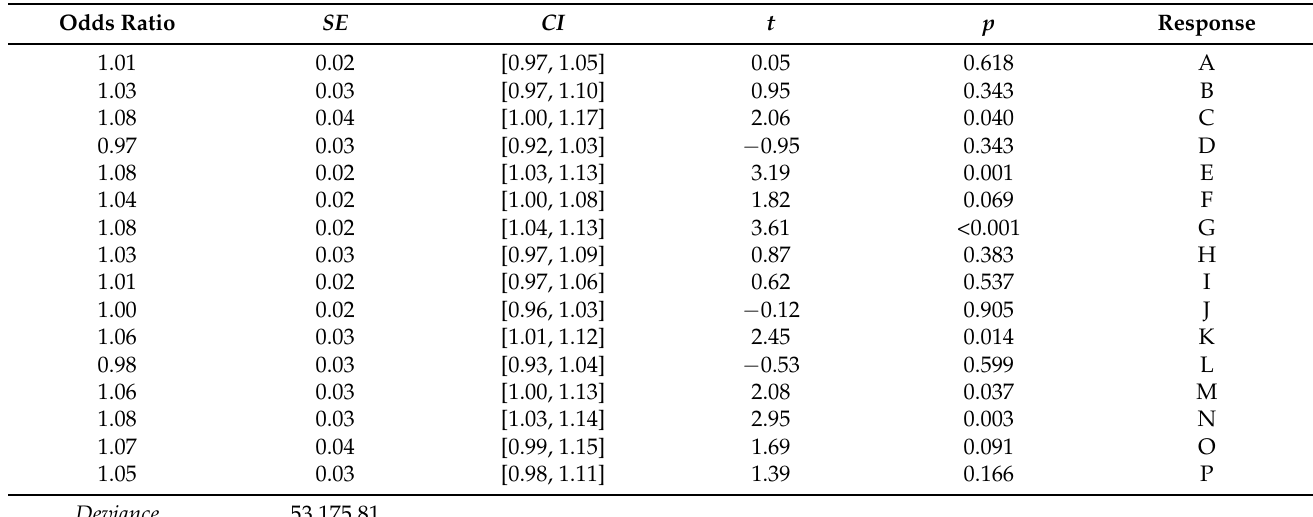
Table A16. Emospace widget response multinomial logistic regression model for openness concerning the space of a widget as clusters.